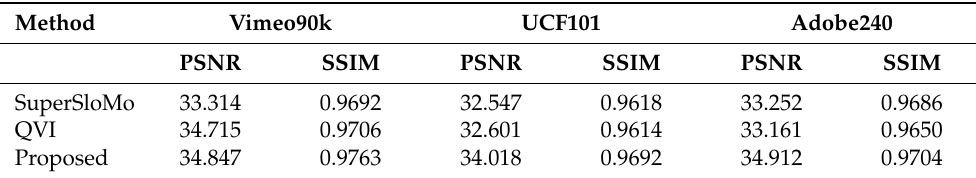
Table 1. Objective performance comparison of the proposed method.